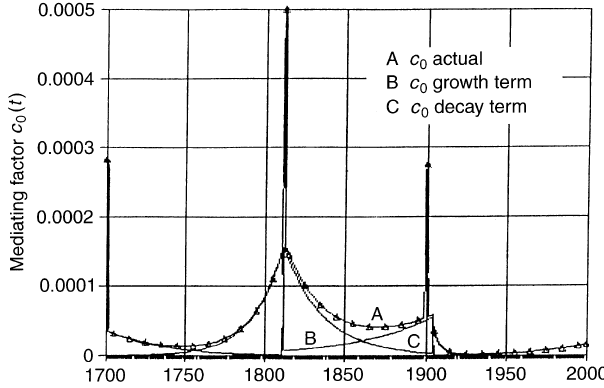
Fig. 4. Mediating factor (growth